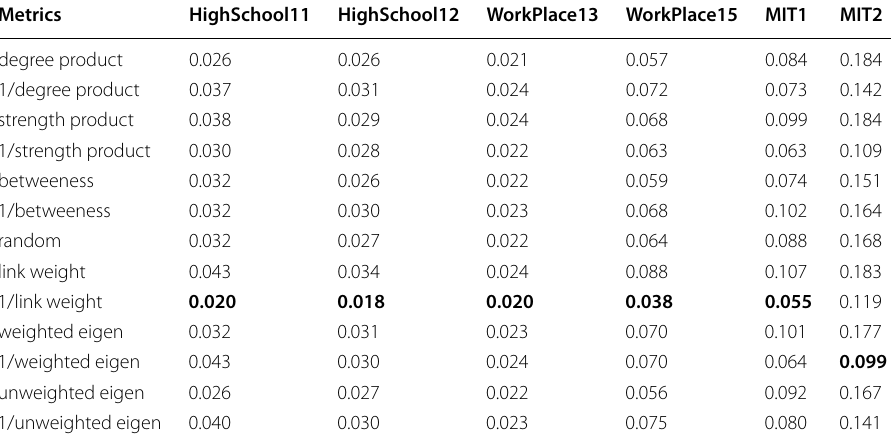
The lowest average prevalence value for each dataset is highlighted in bold